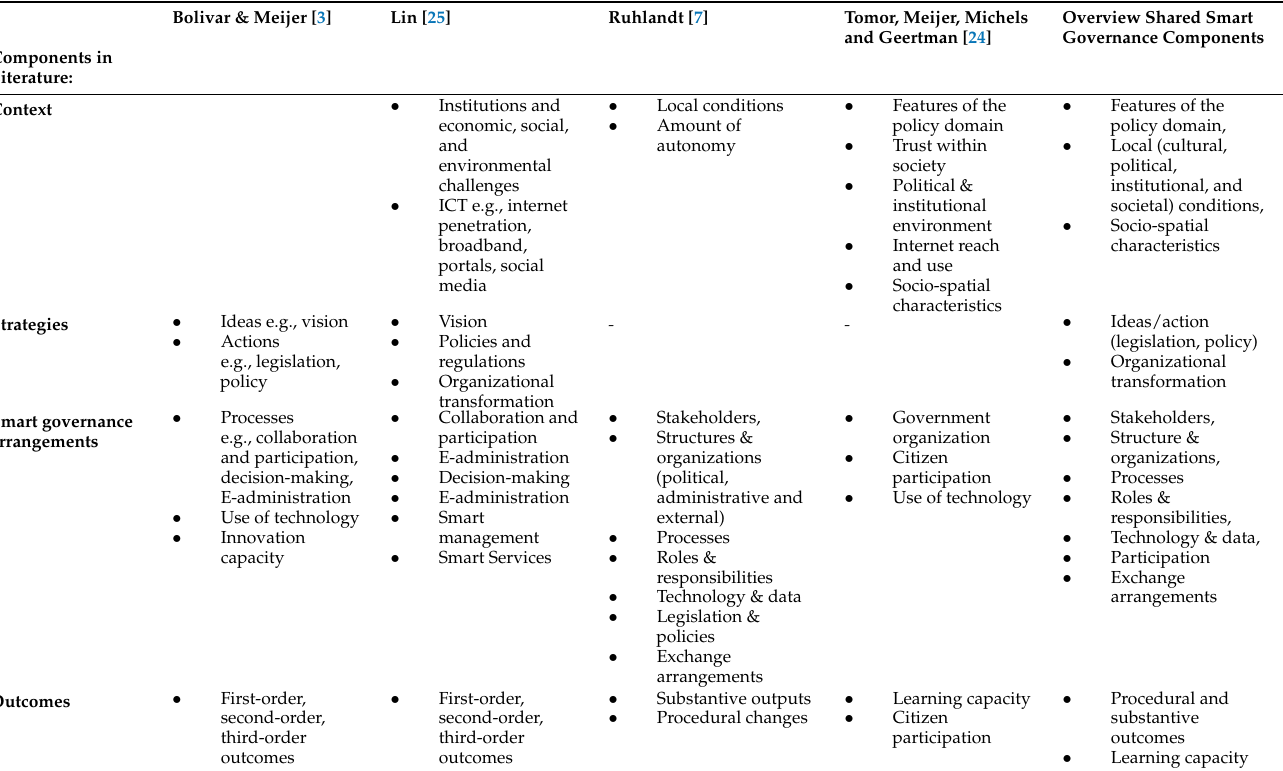
Table 1. Components of smart governance based on smart city